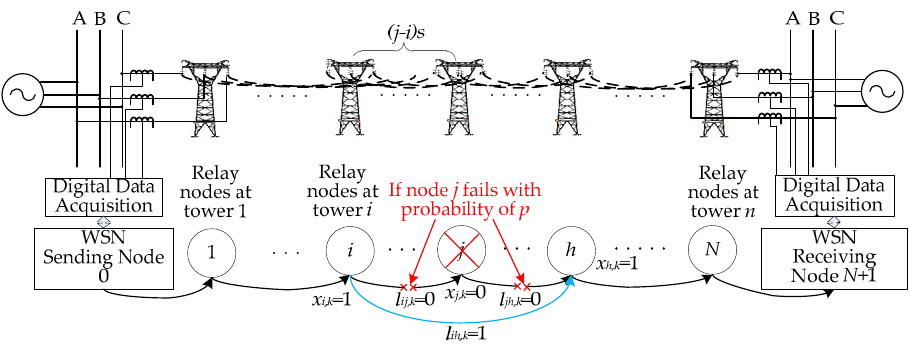
Figure 3. Description of reconstructed communication channel (RCC) model by hop-by-hop relaying.